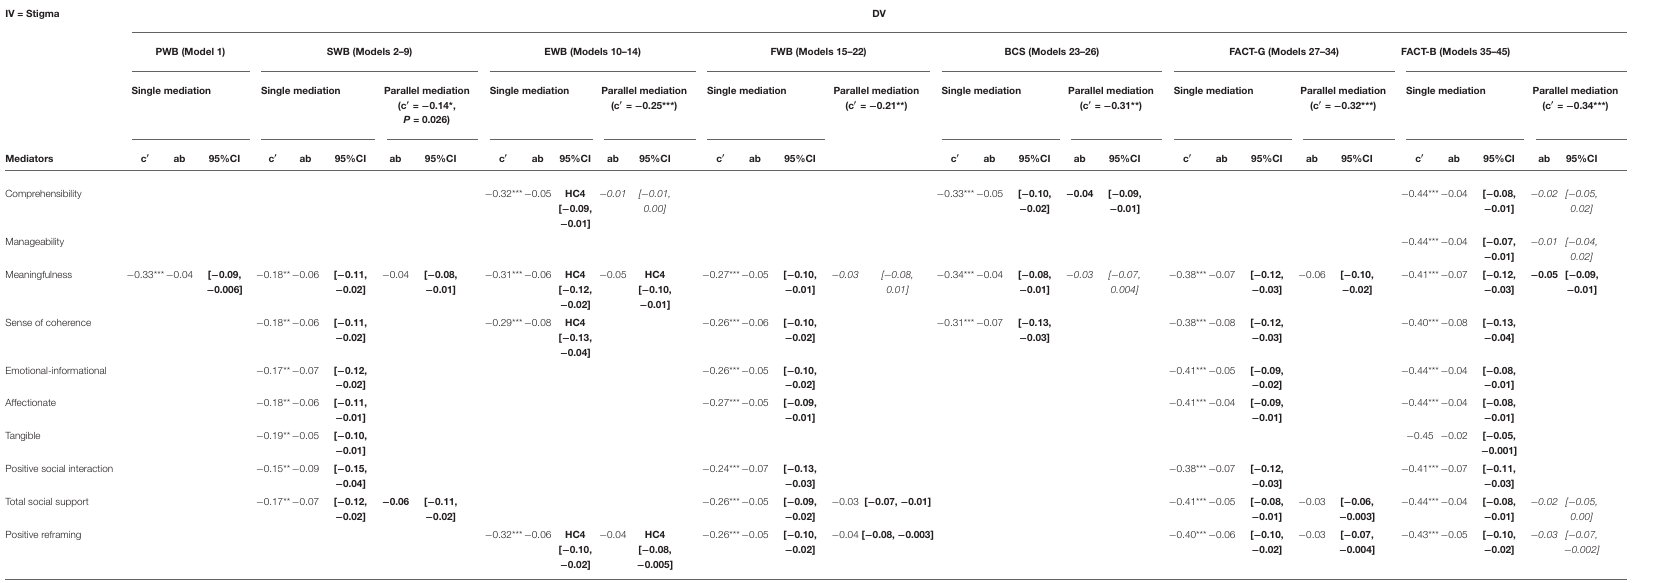
TABLE 3 | Mediation analysis of sense of coherence, social support, and coping behaviors in the effect of stigma on HRQoL ( N =